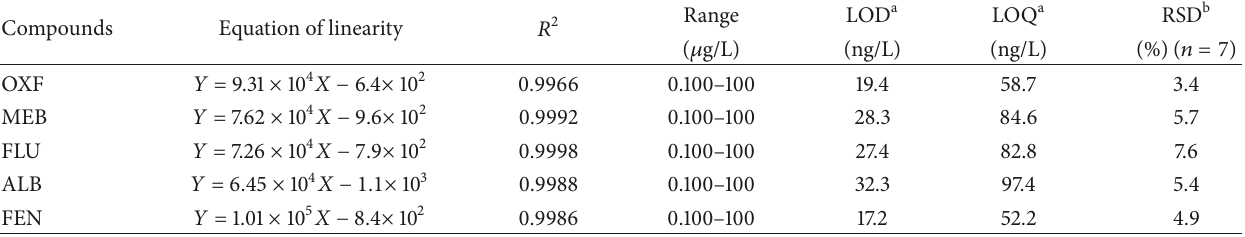
Table 1: Analytical performance and results for HPLC-UV determination of five BMZs using magnetic graphene. Compounds Equation of linearity